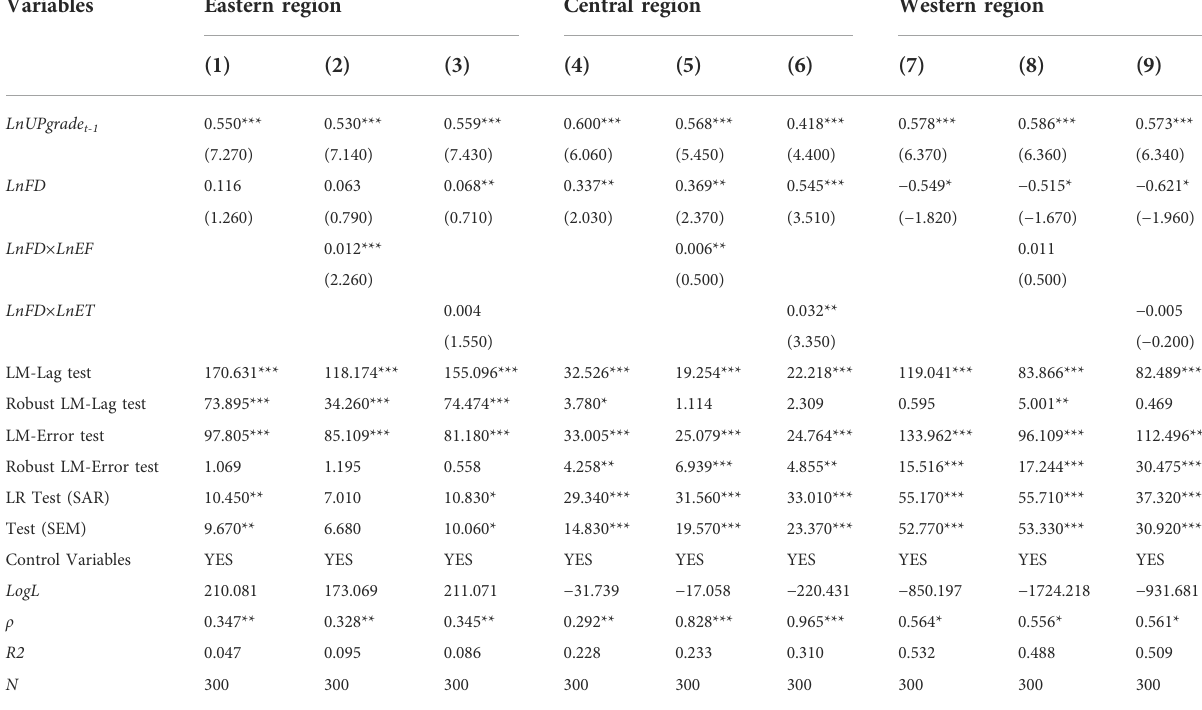
TABLE 11 Estimated results of regional heterogeneity